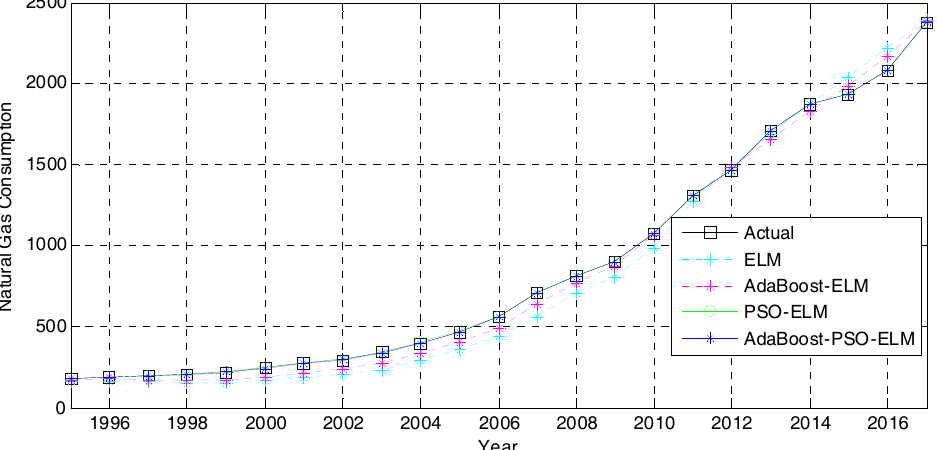
Figure 9. Prediction Performance of Different Models.